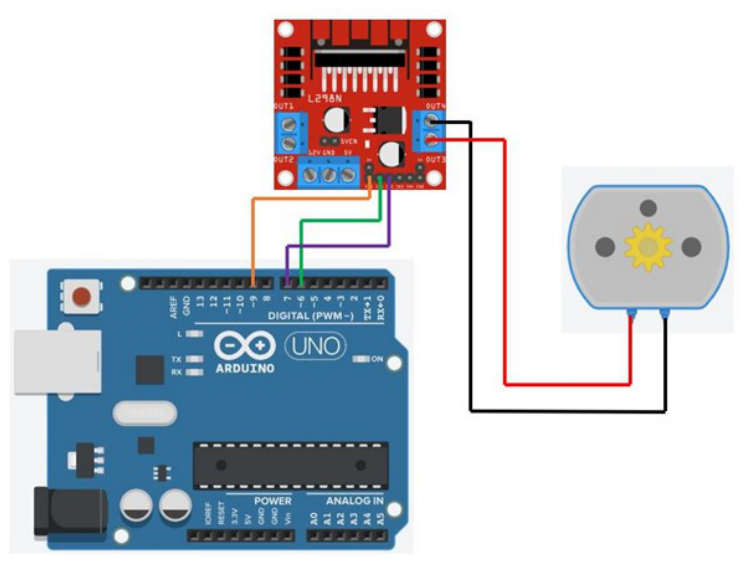
Figure 5. Schematic of the linear actuator